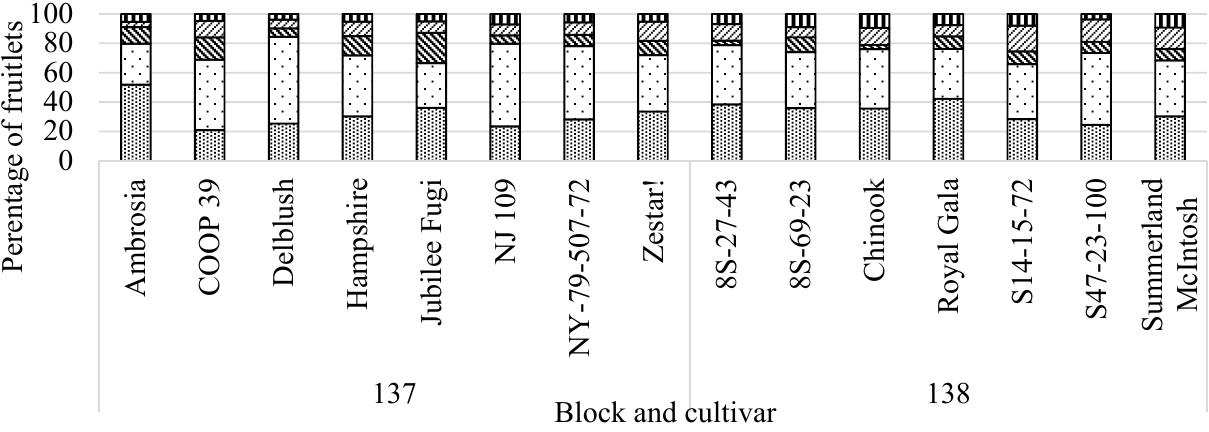
Figure 2. Categories of fruitlets observed in August (from 2016, 2018 and 2019) following bagging at petal-fall showing differences across cultivars from 2 blocks located at the Kentville Research and Development Centre. Percentage of fruitlets which became fruit (Healthy), did not develop (Failed to develop), were damaged by other pests (Other damage), had secondary damage from European Apple Sawfly (EAS), Hoplocampa testudinea , but dropped from the tree (EAS dropped) and had primary damage and remained on the tree (EAS on tree).